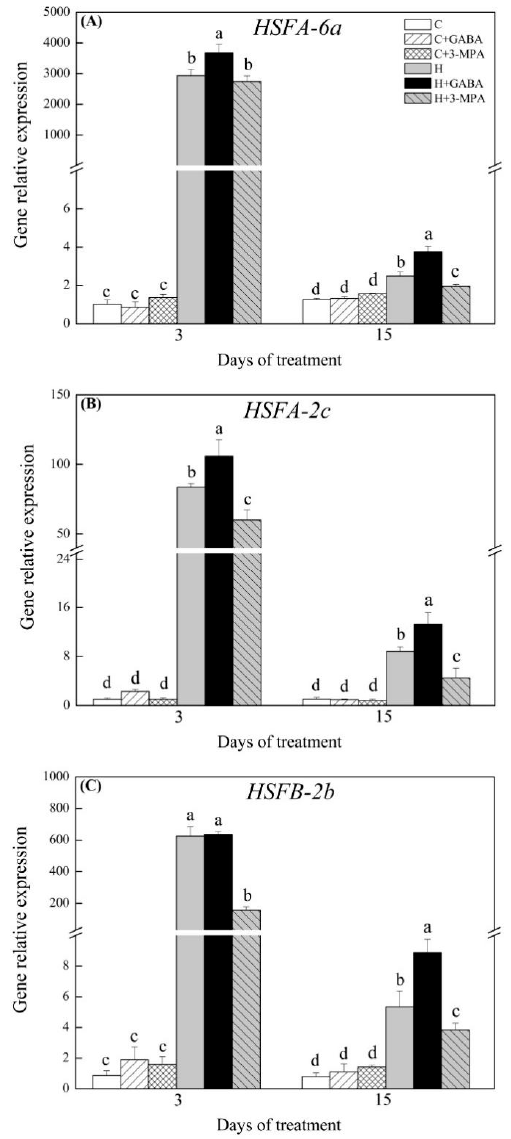
Figure 6. Effects of γ -aminobutyric acid (GABA) and 3-mercaptopropionic acid (3-MPA) on ( A ) HSFA-2a , ( B ) HSFA-2c , and ( C ) HSFB-2b relative expression in leaves of creeping bentgrass at 3 and 15 d of 23/18 (normal condition) or 38/33 °C (heat stress). Vertical bars above columns indicate ±standard error (SE) of means ( n = 4) and different letters above columns indicate significant differences ( p ≤ 0.05). C: control; C+GABA: control + GABA; C+3-MPA: control+3-MPA; H: heat; H+GABA: heat + GABA; H+3-MPA: heat+3-MPA.